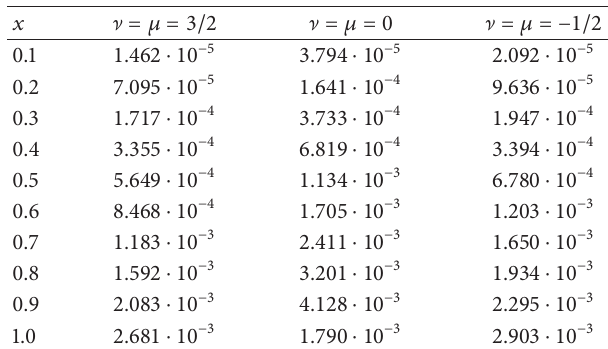
Table 2: Absolute errors using SJGC method at 𝑁 = 16 for Example 4.